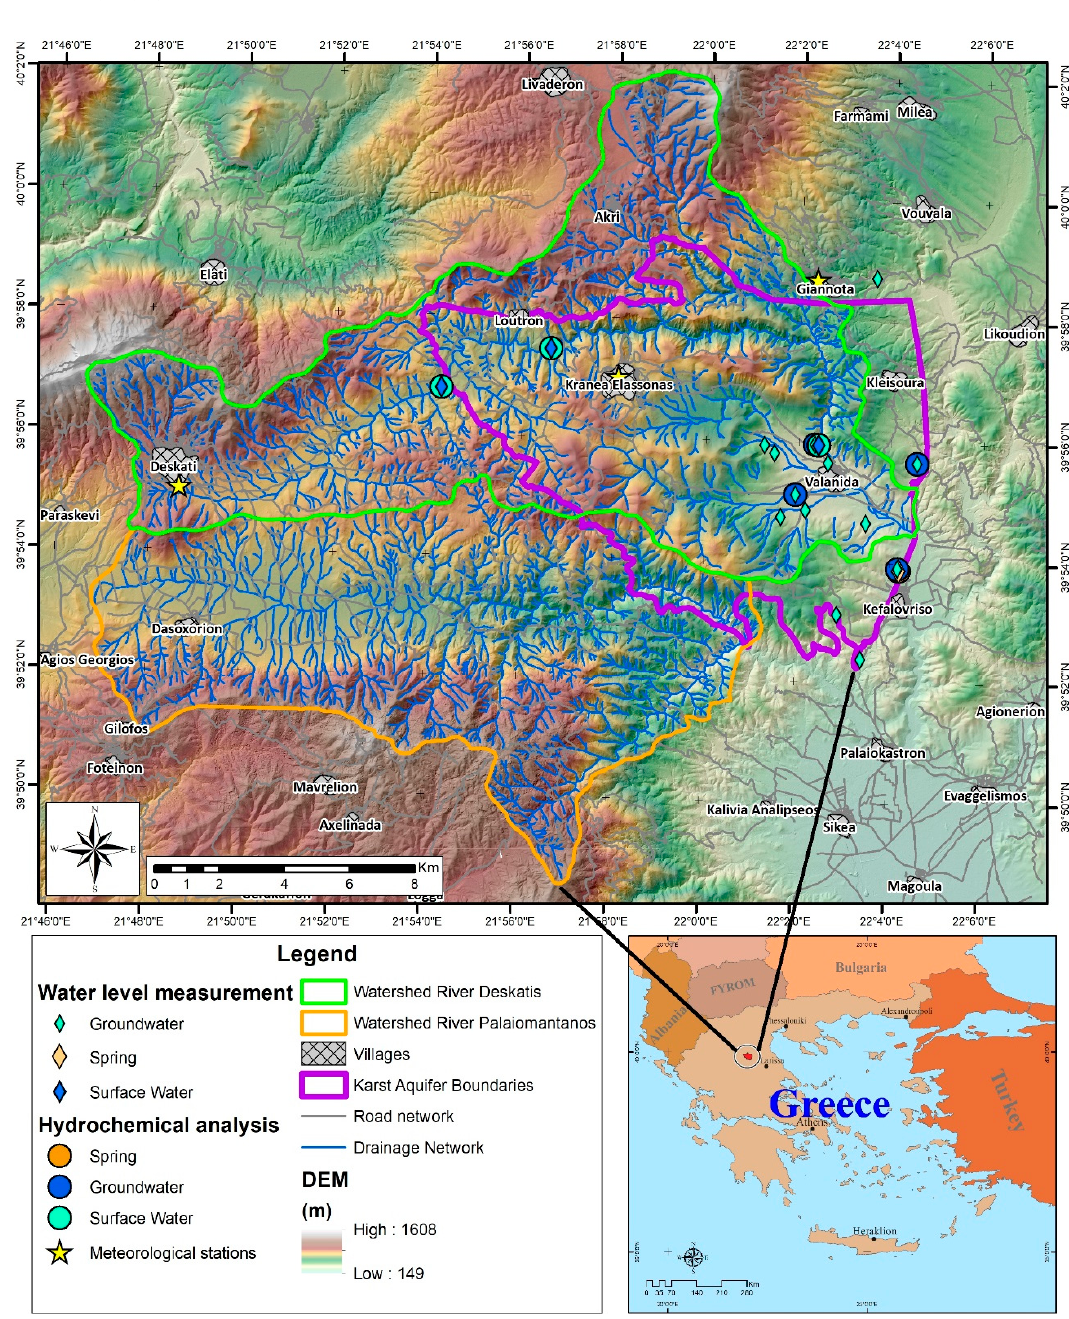
Figure 1. Topographic map of the study area showing sampling and measurement points.